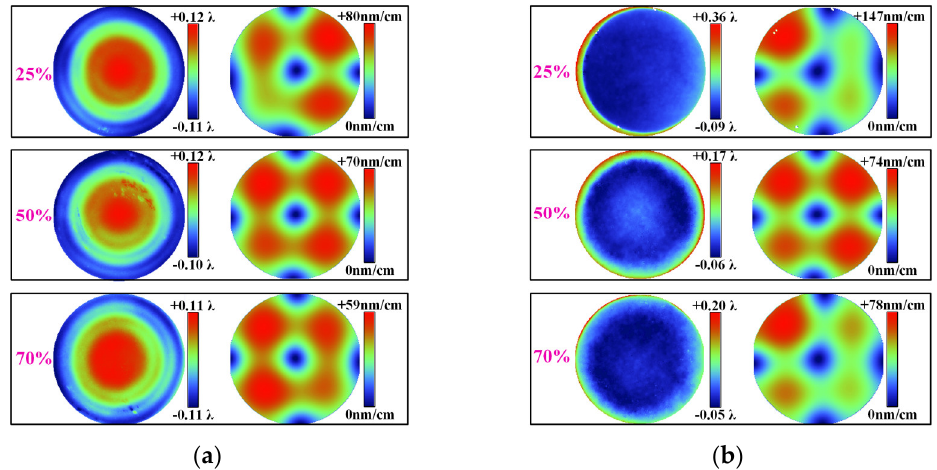
Figure 2. The reflective surface shape and gradient data (de-slope processing) for dielectric films at 25%, 50%, and 70% ambient humidity. ( a ) SiO 2 -substrate dielectric films; ( b ) K9-substrate dielectric films.